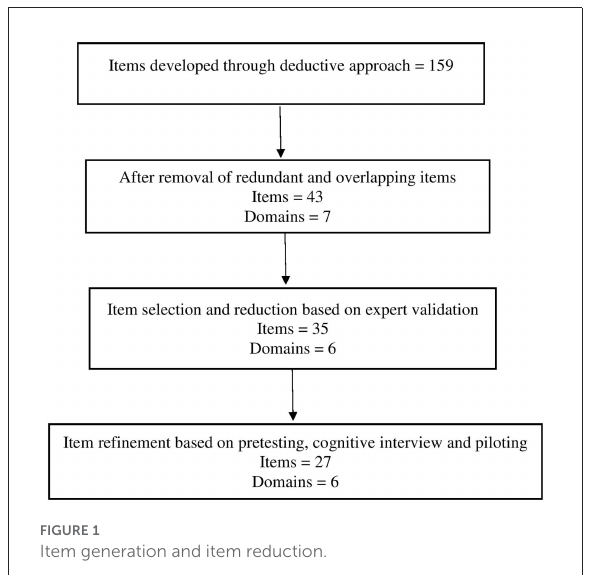
FIGURE1 Item generation and item